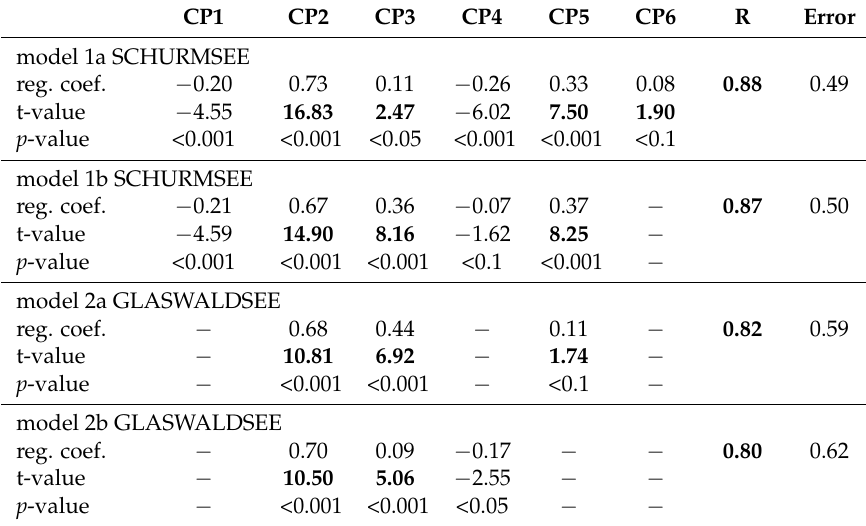
Table 2. Stepwise regression analysis of CPs on Hg accumulation in the two sediment cores: components involved in the variations of Hg accumulation, regression coefficients of the significant CPs explaining Hg accumulation, t-values (with positive relationship to Hg accumulation in bold), p -values, correlation coefficients (R) in bold and errors for the four regression models; models 1a and 2a included all variables; models 1b and 2b excluded pollen data of coniferous tree species.